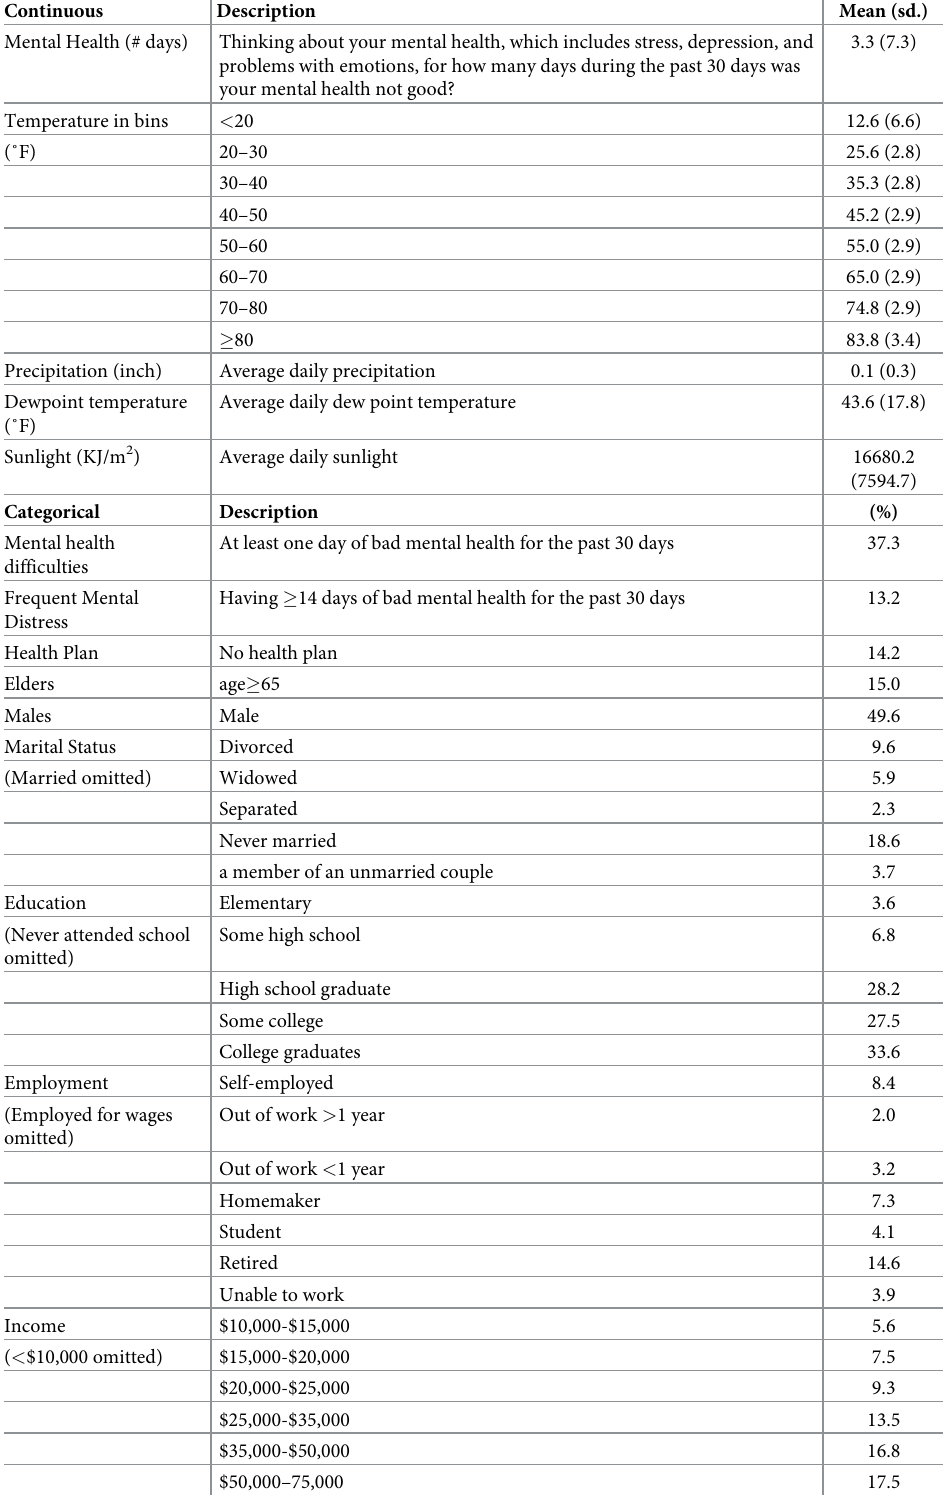
Table 1. Weighted summary statistics of demographical